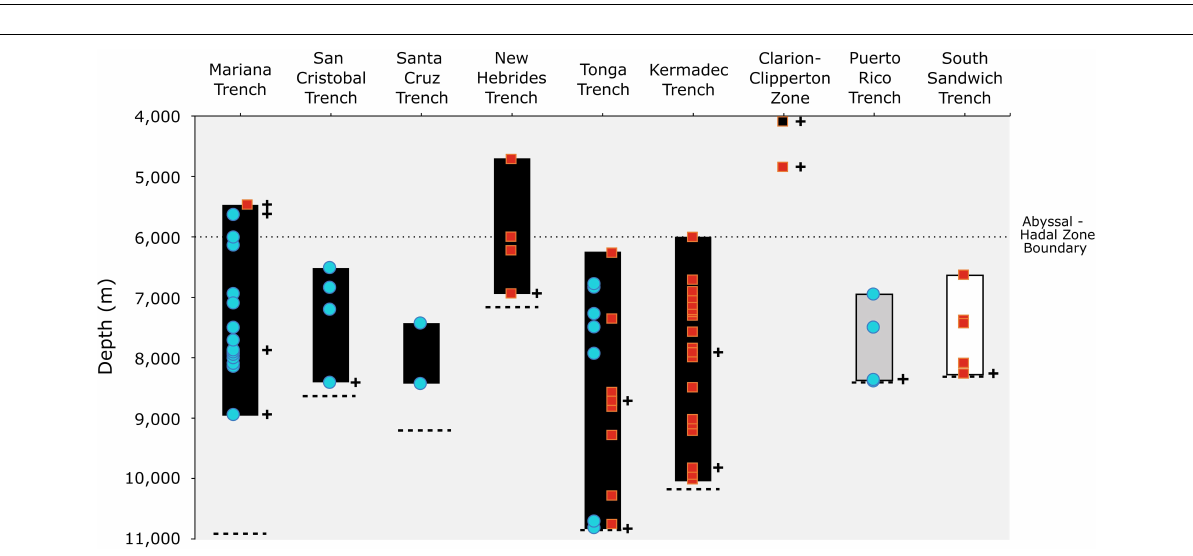
(Dahl, 1959). In particular, the maxilla 2 outer plate had an 8/3 crown setal-tooth arrangement, the maxilliped inner plate had a concave apical margin with 1 small plumose seta and 1